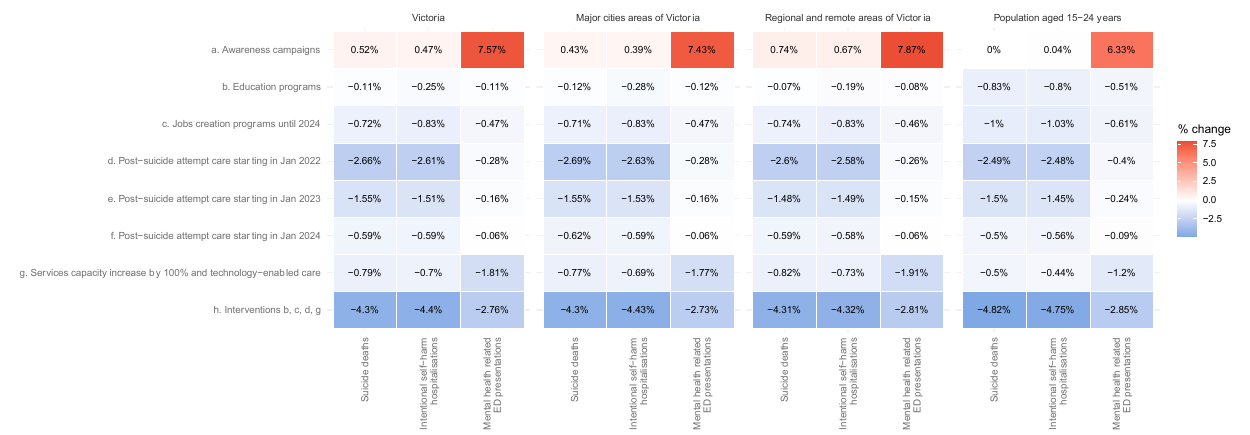
Figure 1. The impact of interventions: a percentage change in the projected cumulative adverse mental health outcomes between March 2020 and March 2026, with several interventions compared to the COVID-19 baseline. The percentage change is calculated from event numbers rounded to the nearest integer.